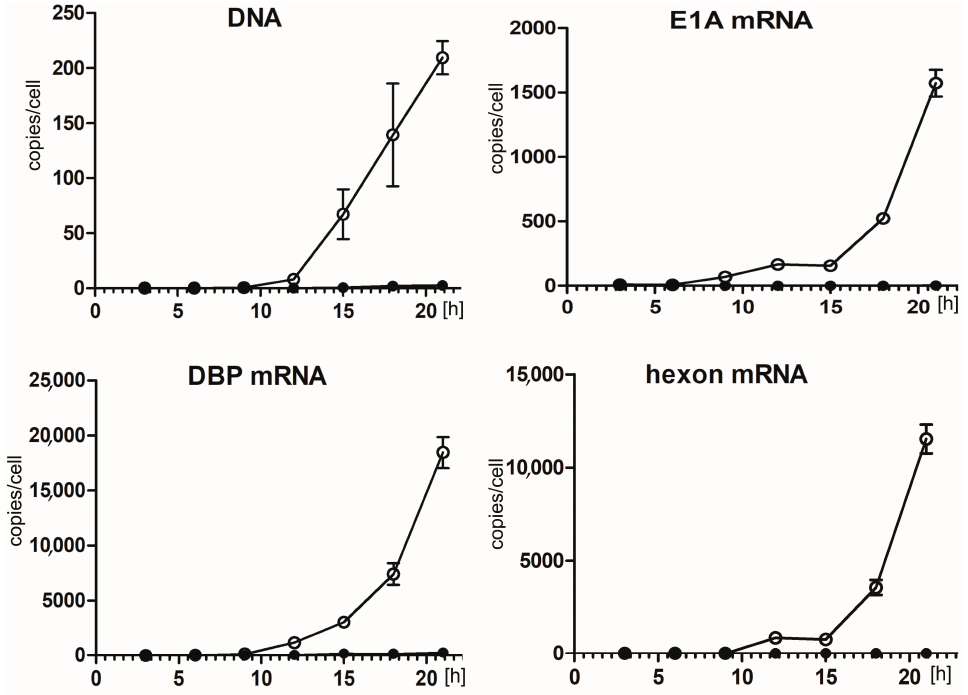
Figure 2. 17-AAG inhibits transcription of AdV5 genes and replication of AdV5 genome. A549 cells infected with HAdV-5, were cultured in the presence of 0.25 μ M 17-AAG, or without 17-AAG, for the specified time. HAdV-5 DNA and mRNAs were quantitated by qPCR. Plotted are numbers of DNA or mRNA copies per cell in cultures with 17-AAG (closed circles) and control cultures (open circles). Plots represent means and SD of the experiment performed in triplicate.